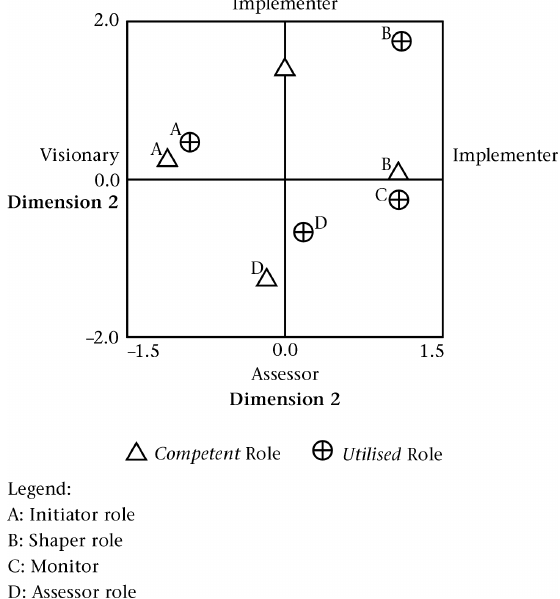
Figure 2: Symmetrical normalisation graph (correspondence analysis) for role congruence between utilised roles